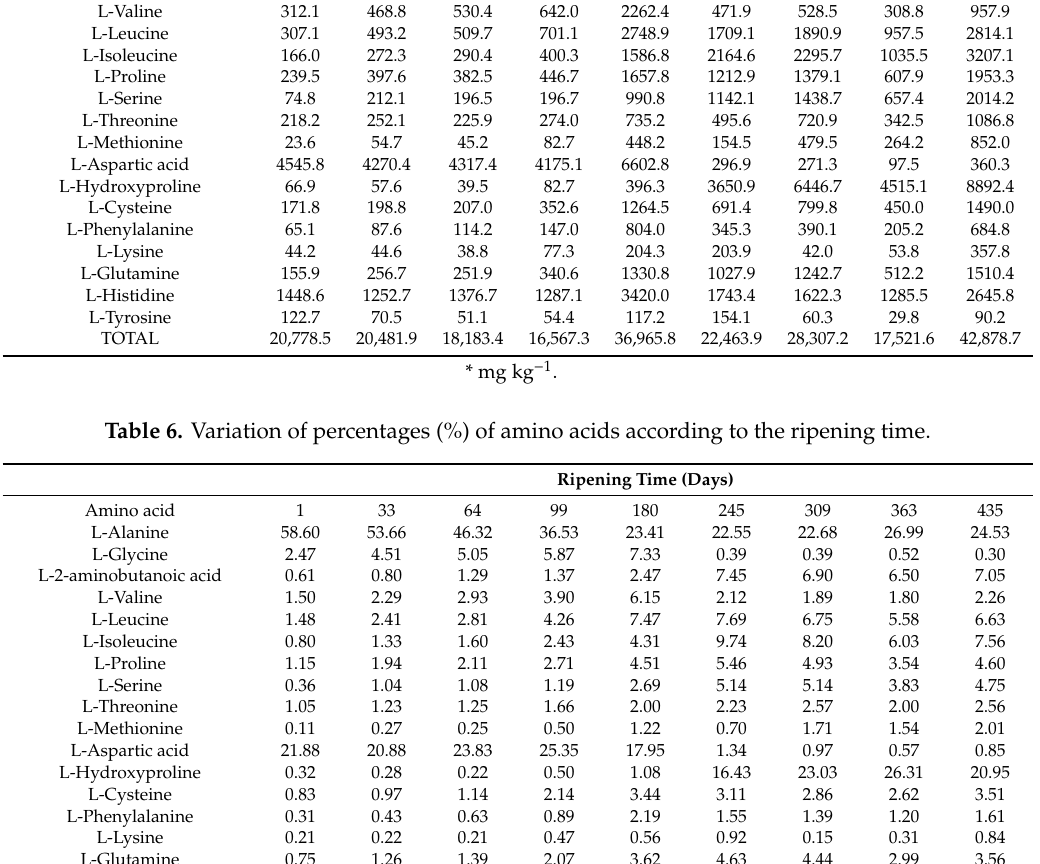
Table 5. Variation of concentration * of amino acids according to the ripening time. Amino acid